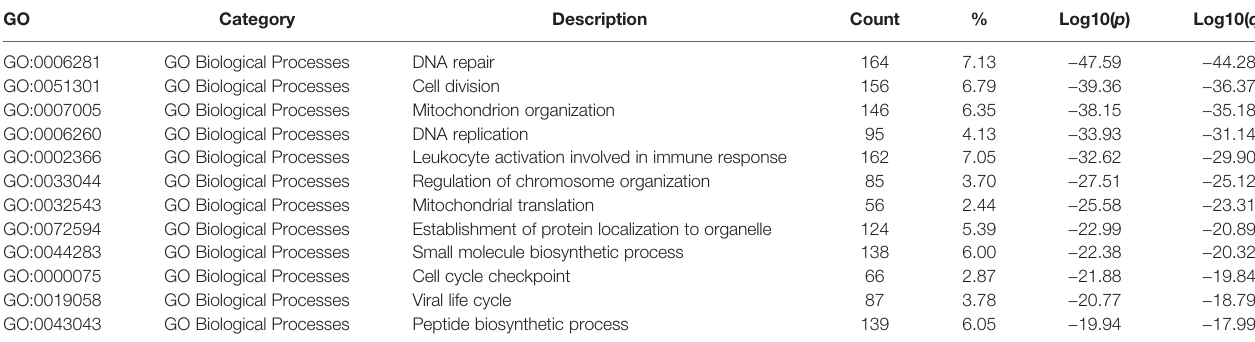
TABLE 1 | Top clusters with their representative enriched GO terms (one per